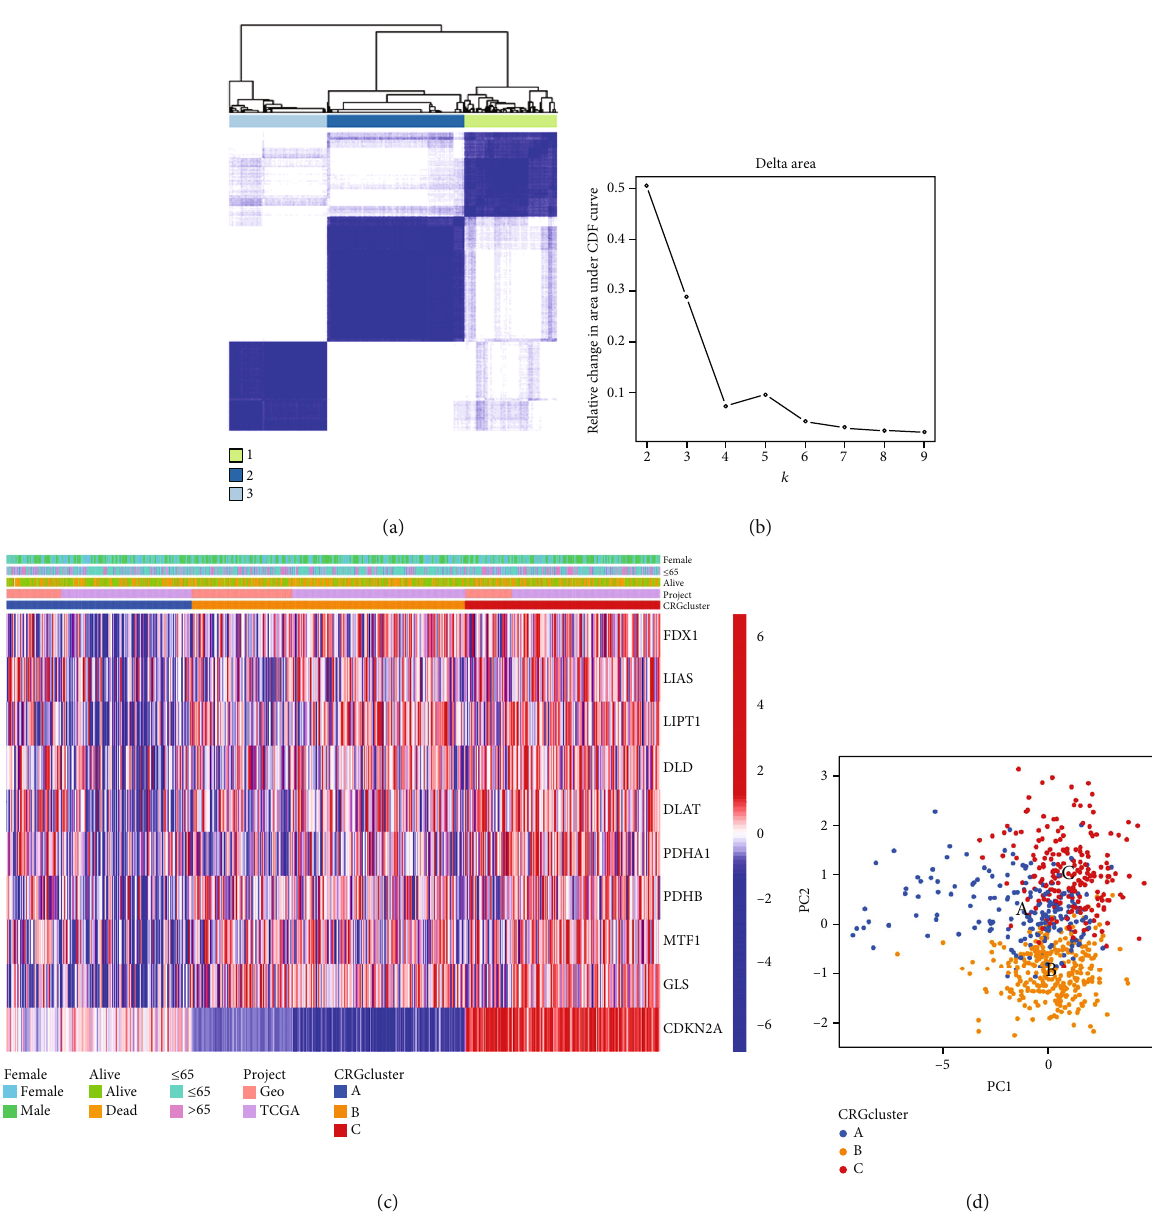
Figure 2: Clustering analysis based on the expression of CRGs. (a) Clustering according to a consensus at K = 3 . (b) The relative change in the area under the CDF curve for the values of K ranges from 2 to 9. (c) A heat map of the CRG and its various clinical aspects, organized into three subclusters of the CRG. (d) PCA under the CRG modi fi cation pattern. CRG: cuproptosis-related gene; PCA: principal component